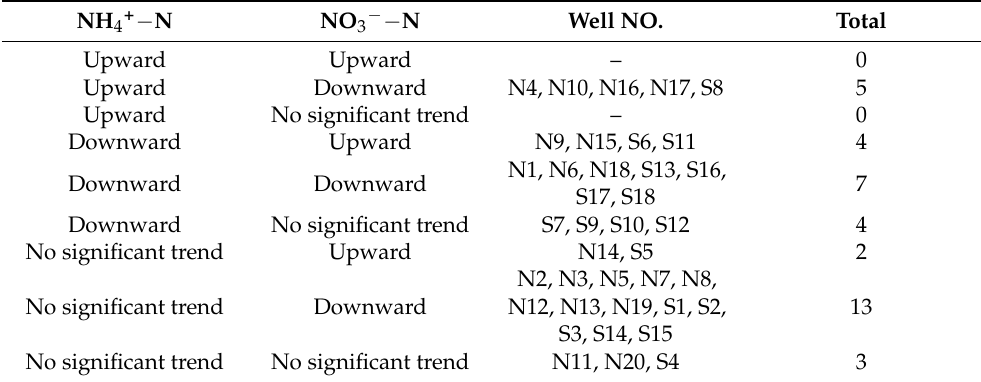
Table 3. Cross-comparison of trends between ammonium–N and nitrate–N concentrations in all monitoring